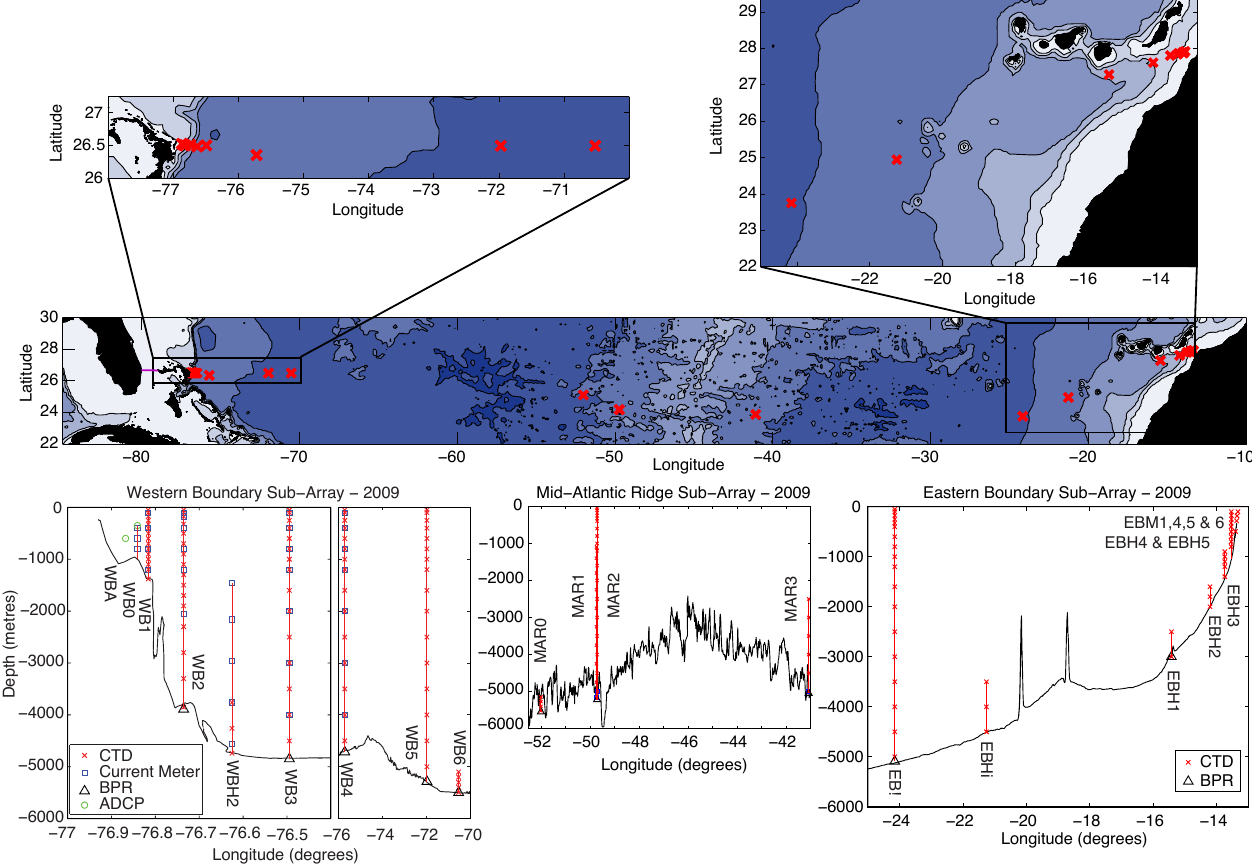
Fig. 2. Map of the Rapid-WATCH moored array in Autumn 2009 (the location of the Florida Straits cable is also shown in purple). Red crosses correspond to mooring locations, enlargements of the western and eastern boundary arrays are shown. Schematic figures of the moor- ings are given below, including instrumentation, topography and mooring nomenclature. Sub-figures courtesy of Darren Rayner (National Oceanography Centre, Southampton,